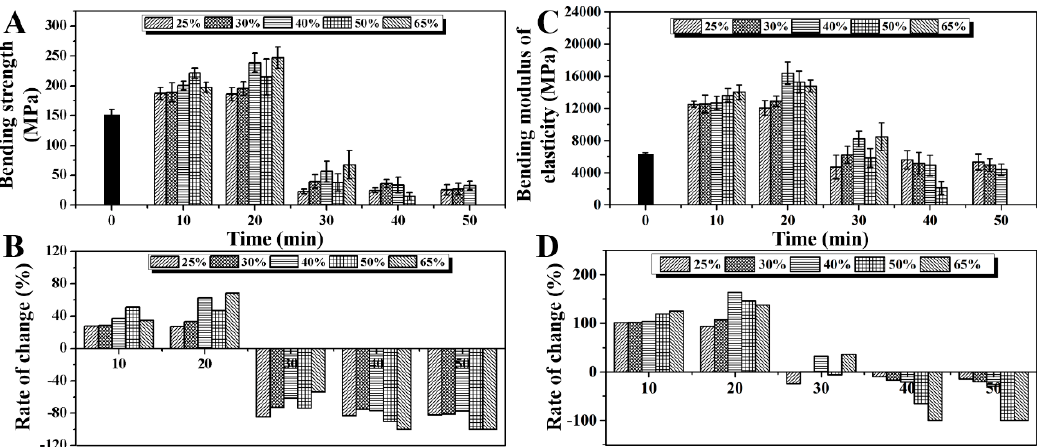
Figure 6. ( A ) Results of bending strength of bamboo before and after saturated steam heat treatment under different moisture content conditions, and ( B ) the change rate with the prolongation in heat treatment time. ( C ) Results of modulus of elasticity of bamboo before and after saturated steam heat treatment under different moisture content conditions, and ( D ) the change rate with the prolongation in heat treatment time.